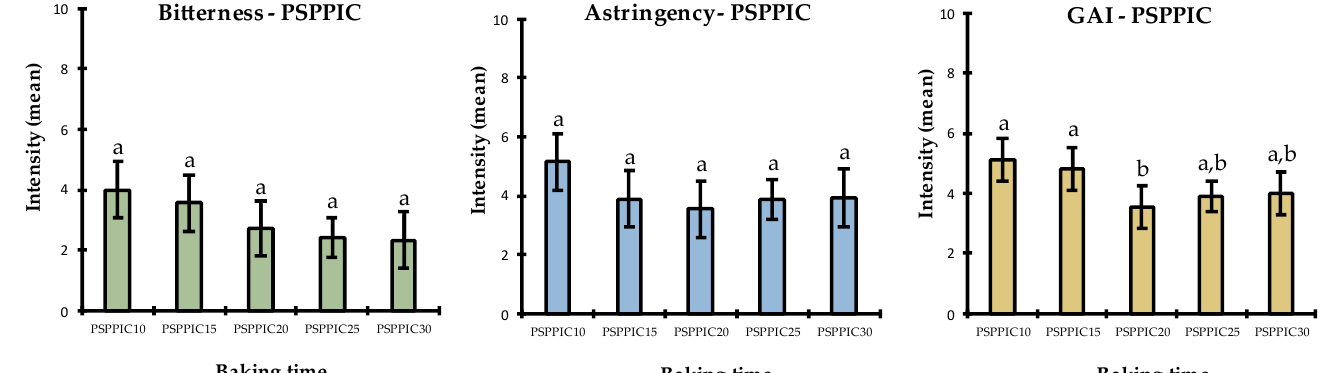
Figure 5. Mean intensities of the three attributes (bitterness, astringency, and aroma) assessed by the sensory panel in PSPPIC samples over baking time. Significantly different means ( p < 0.05) are represented by letters above each bar. PSPPIC10 = pea flour cake baked for 10 min, PSPPIC15 = pea flour cake baked for 15 min, PSPPIC20 = pea flour cake baked for 20 min, PSPPIC25 = pea flour cake baked for 25 min, PSPPIC30 = pea flour cake baked for 30 min, and GAI = global aromatic intensity.